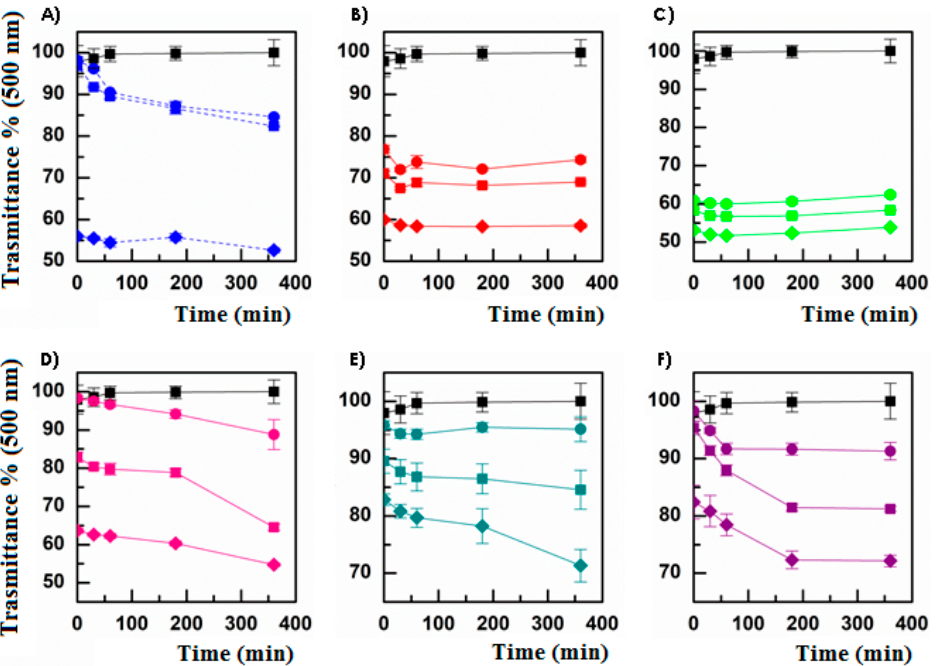
Figure 1. Transmittance percentage at 500 nm of mucin dispersion 1 mg/mL (black), ( A ) PAA (blue); ( B ) INU-EDA-RA micelles (red); ( C ) INU-EDA-RA-PEG micelles (green); ( D ) INU-EDA-TAU-RA micelles (pink); ( E ) INU-EDA-RA-CAR micelles (petrol green); ( F ) INU-EDA-RA-CRE micelles (violet) at the following concentrations: 0.5 mg/mL (circle), 1 mg/mL (square), and 5 mg/mL (rhombus). The obtained values recorded at different concentrations resulted in statistically significant differences ( p < 0.05).